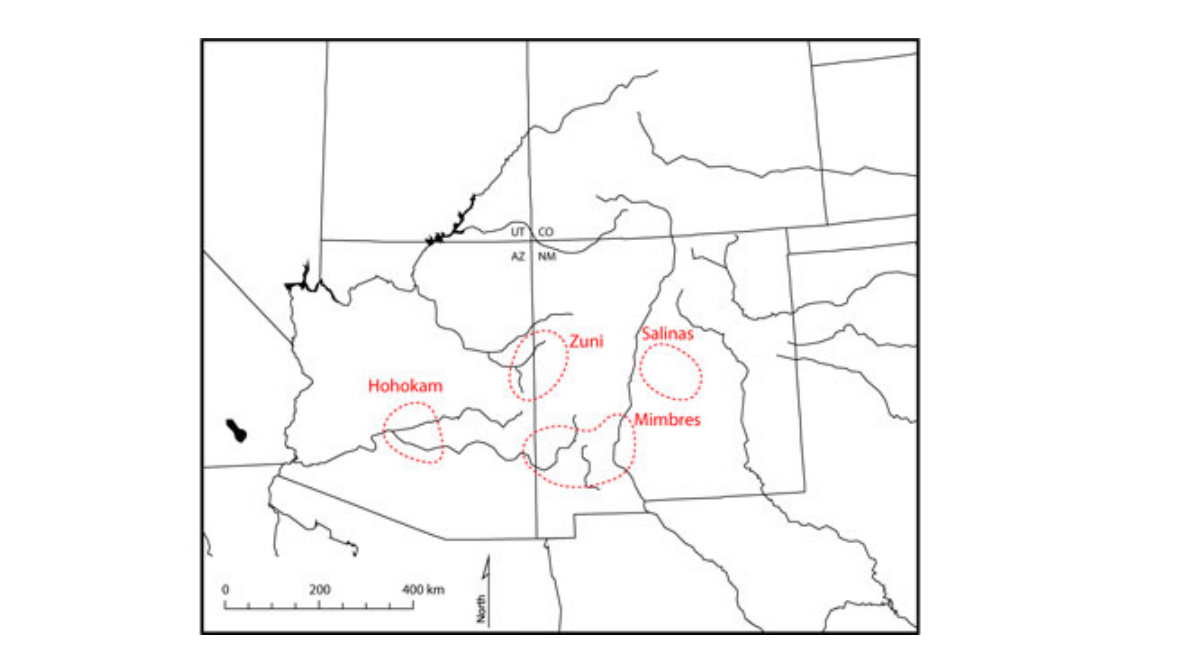
Fig. 1 . US Southwest showing the regions of the four